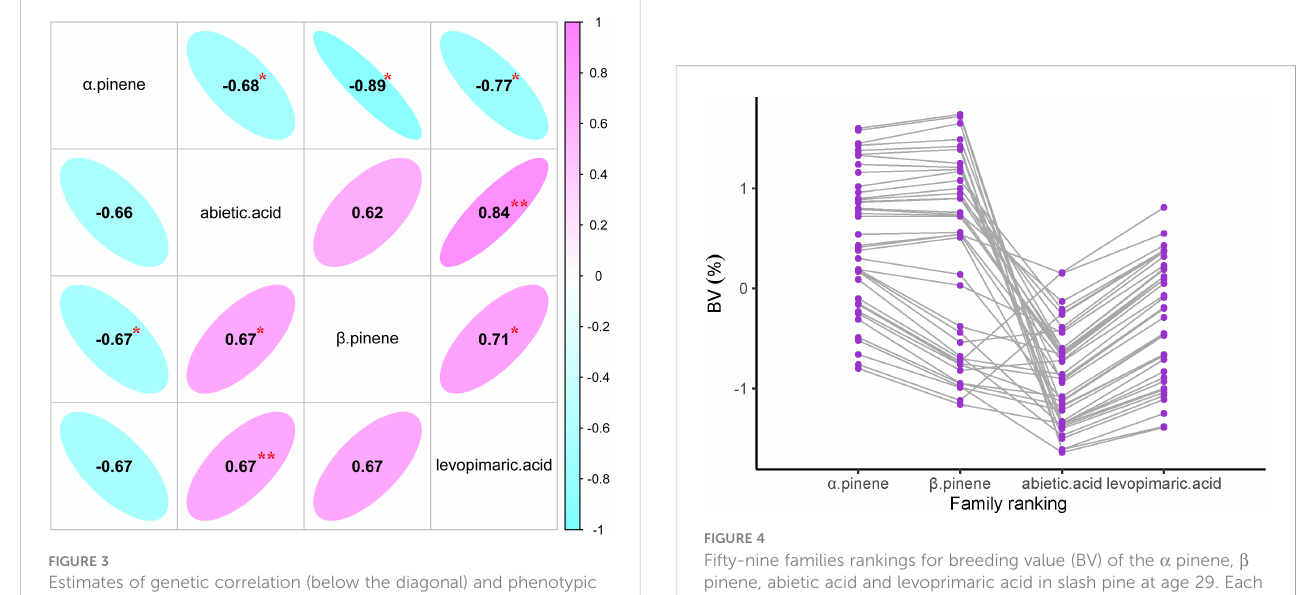
The b pinene and abietic acid had the weakest genetic correlation ( r g = 0.62) and phenotypic correlation ( r p = 0.67). Interestingly, the genetic correlation ( r g = 0.67) and phenotypic correlation ( r p = 0.84) between the two diterpenes (abietic acid and levoprimaric acid) were stronger than those between monoterpenes and diterpenes.